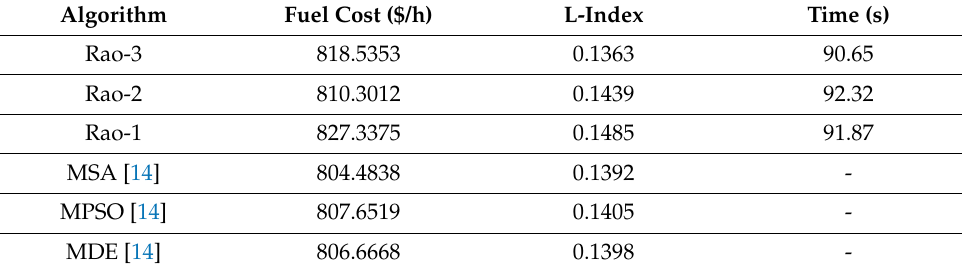
Table 6. Case 4: VSE during contingency results in the IEEE 30-bus